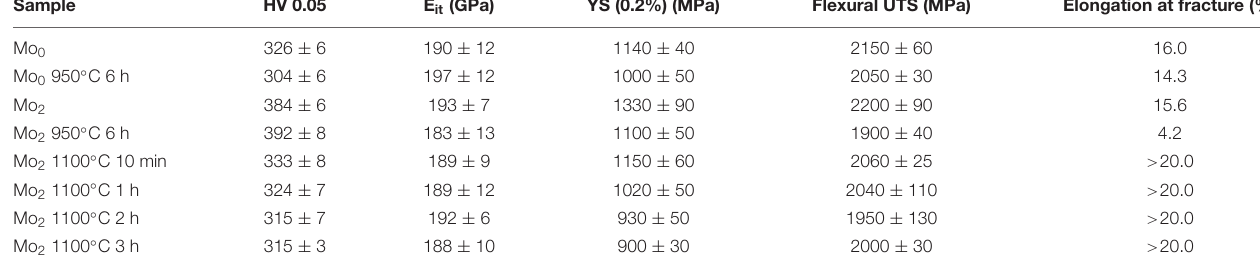
TABLE 4 | Overview of mechanical properties for all tested conditions for Mo 0 and Mo 2 . Sample